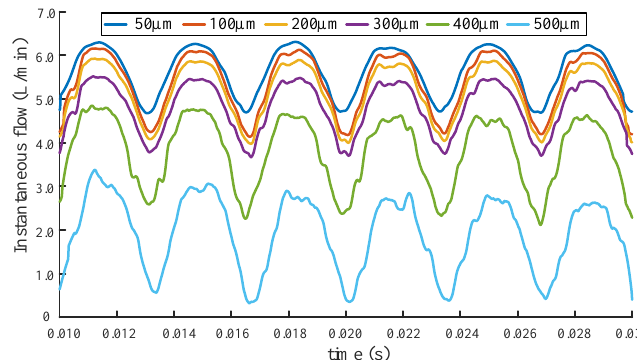
ff erent end wear gaps. Figure 11. Comparison graph of instantaneous simulation flow rate under different end wear gaps.